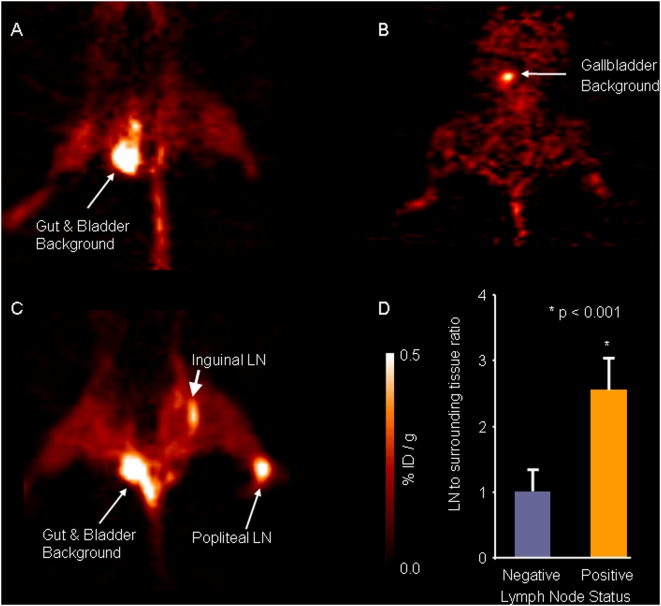
[18F]FEAU-PET imaging of mice with and without positive lymph node metastases.Representative coronal views of (A) a control animal with positive SLN injected with saline and (B) a mouse without tumor injected with NV1023, showing accumulation of radioactive signals in the gut, gallbladder and bladder. (C) A coronal view of a mouse with positive popliteal and inguinal lymph node metastases injected with NV1023. Positive PET signal was detected only in positive lymph nodes (white arrows). (D) The lymph node-to-surrounding tissue radioactivity ratios were measured in the PET scans; negative lymph nodes (blue column, n = 10), positive lymph nodes (orange column, n = 8).